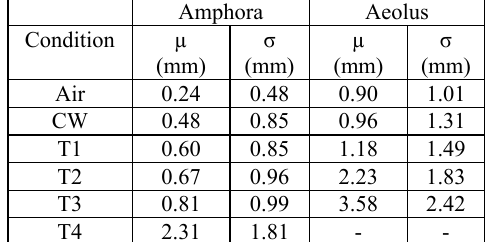
Table 6: Geometrical error between point clouds reconstructed with active and passive